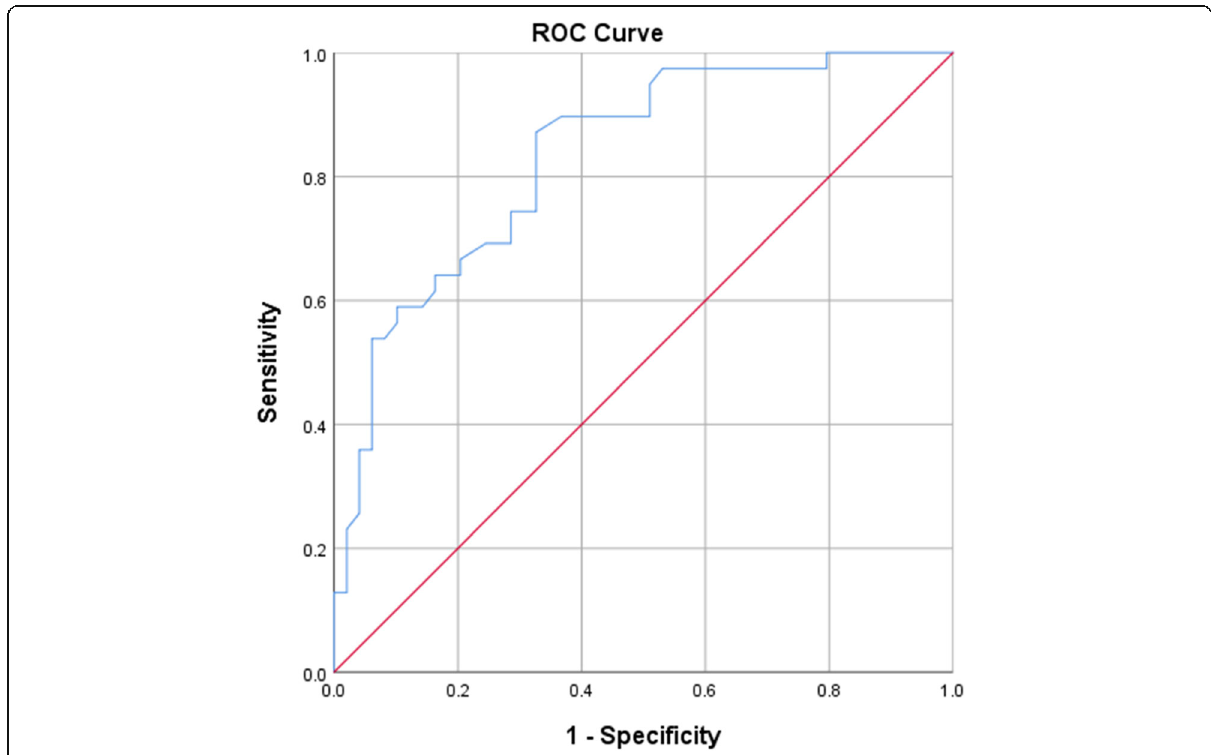
Fig. 4 ROC curve showing the ability of preoperative collapsibility index of IVC to predict hypotension after